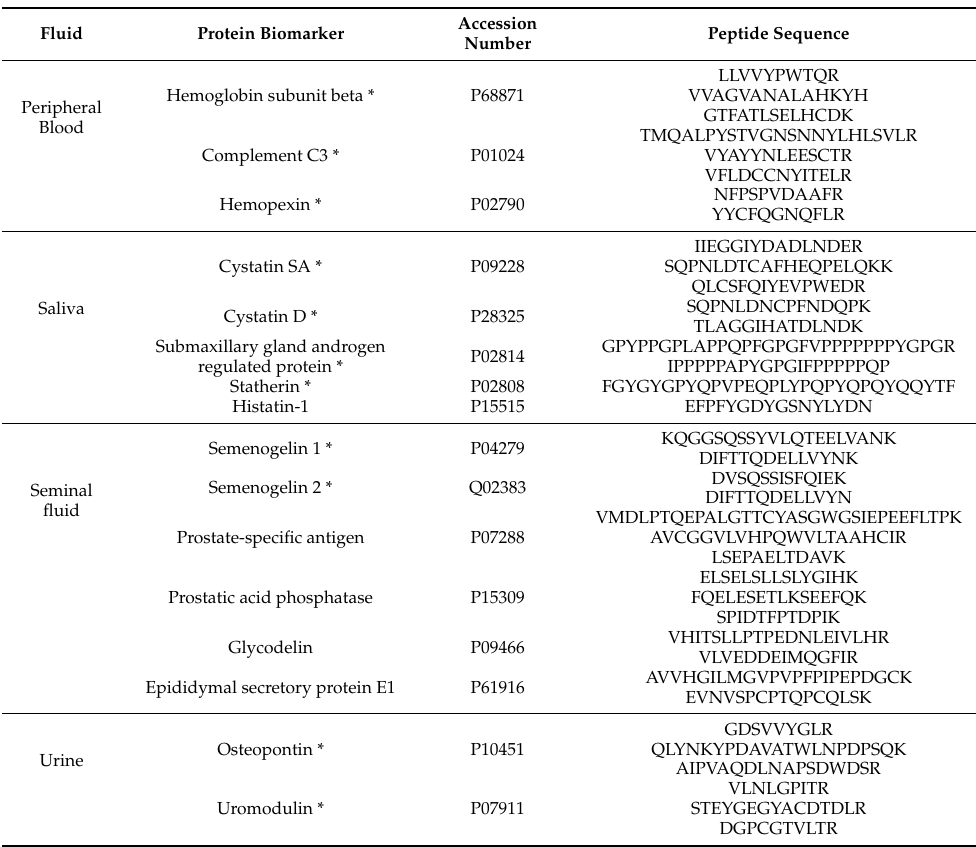
Table 2. Biomarker candidates including peptide